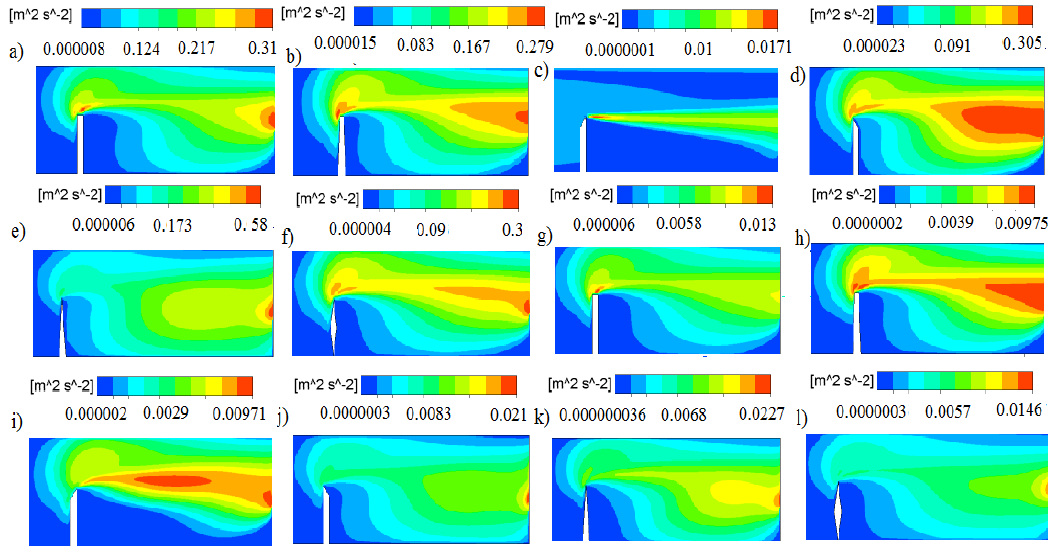
Figure 5. Profiles of TKE for different baffles at Re = 20, 000 [a-f] and Re = 1, 00, 000